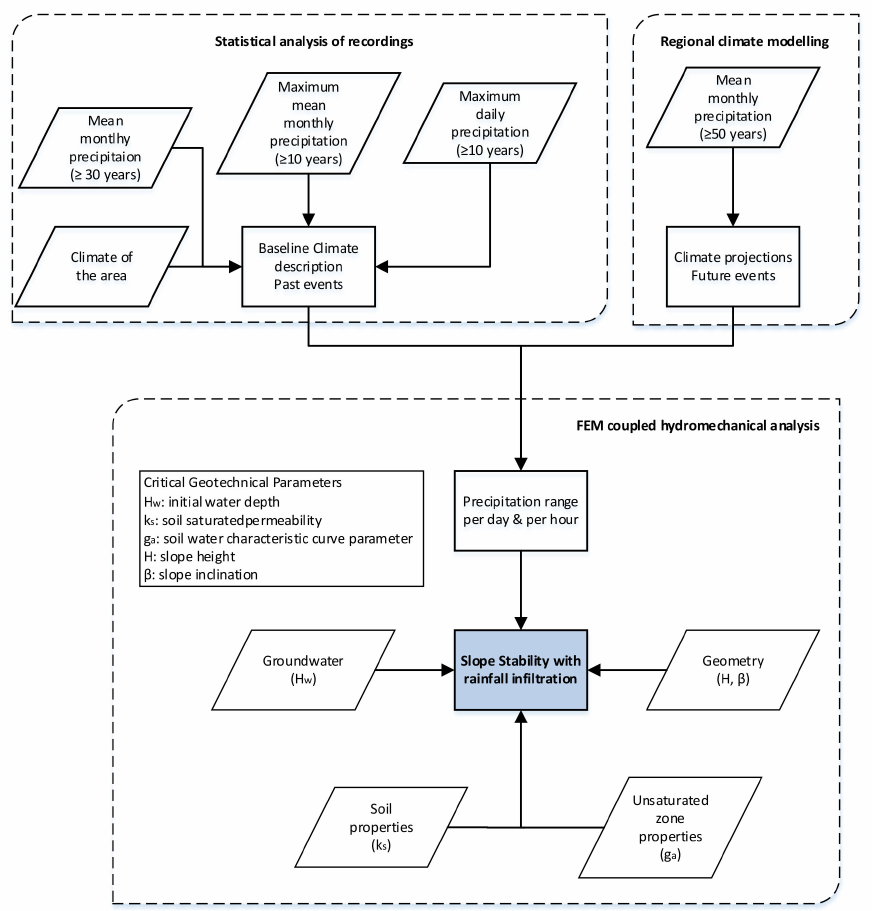
Figure 1. Flowchart presenting an overview of this work’s